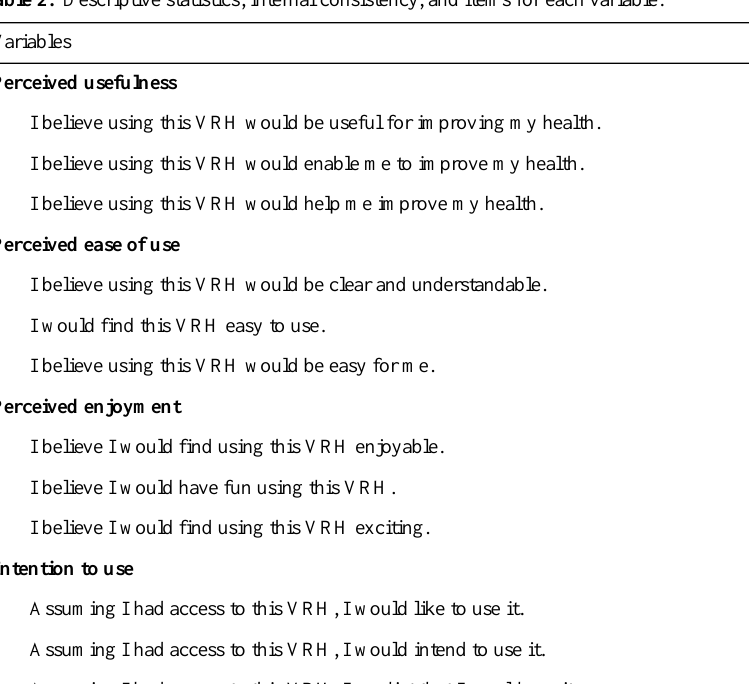
Table 2. Descriptive statistics, internal consistency, and items for each variable.